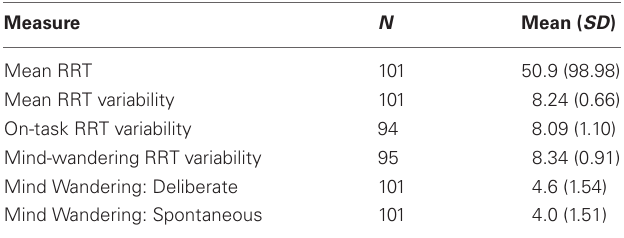
Table 1 | Means (SD) for all MRT measures, and for trait mind wandering questionnaires (deliberate and spontaneous) ( N = 101).